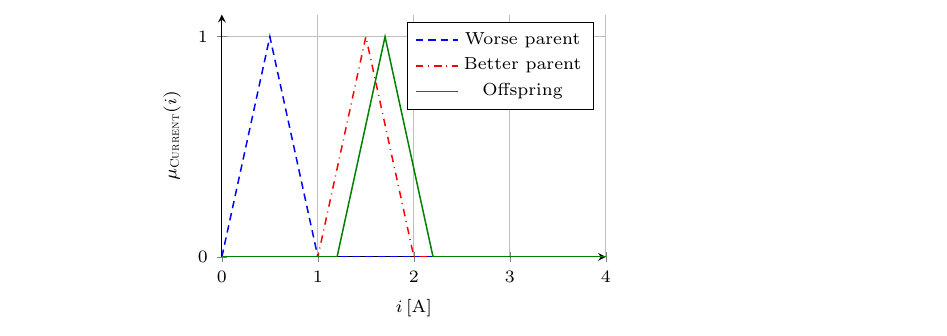
Figure 6. In the introduced example the parents are shifted to the two sides in order to visualize the deviation. The fitness value of the better parent is 80% better than that of the worse parent, that is why, the offspring is much closer to the the better